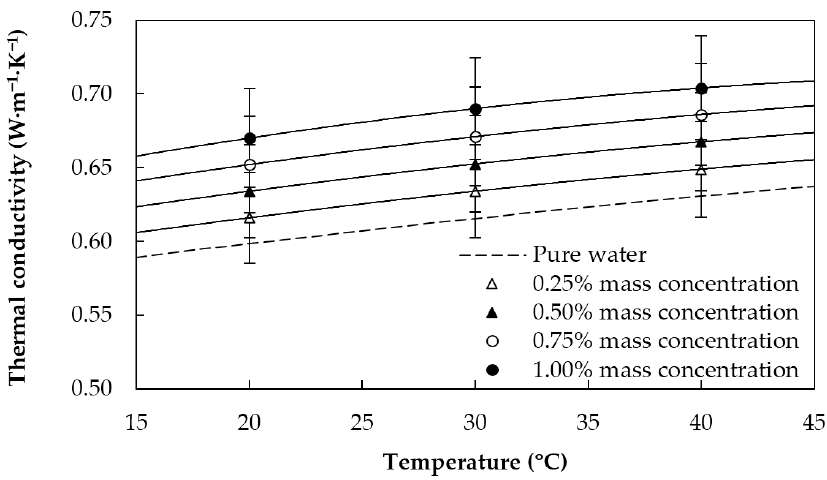
Figure 5. Thermal conductivity of the sulfonic acid-functionalized graphene nanoplatelet water-based nanofluids and water [37].